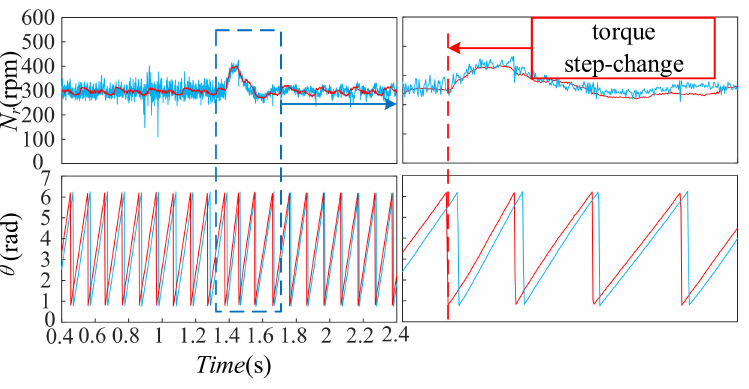
Figure 15. Tracking performances of speed and position during the torque step-change (the red line represents the actual value, and the blue line represents the estimated